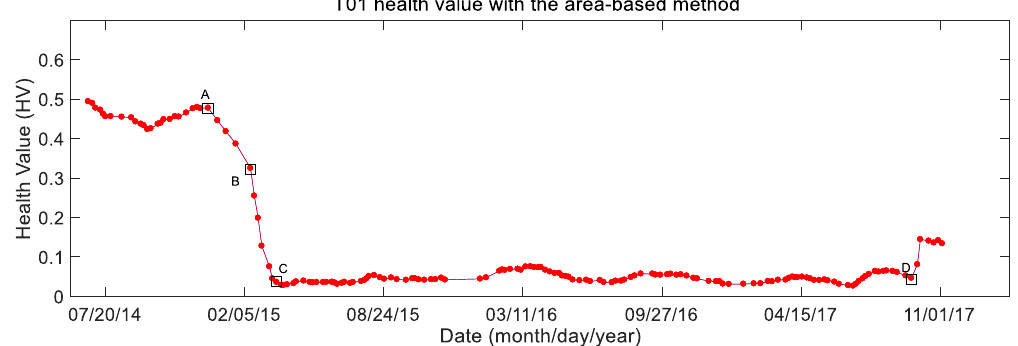
Figure 6. Health result of T01 obtained using the probabilistic area metric (PAM) method in the maximum wind power tracking region (MWPTR).